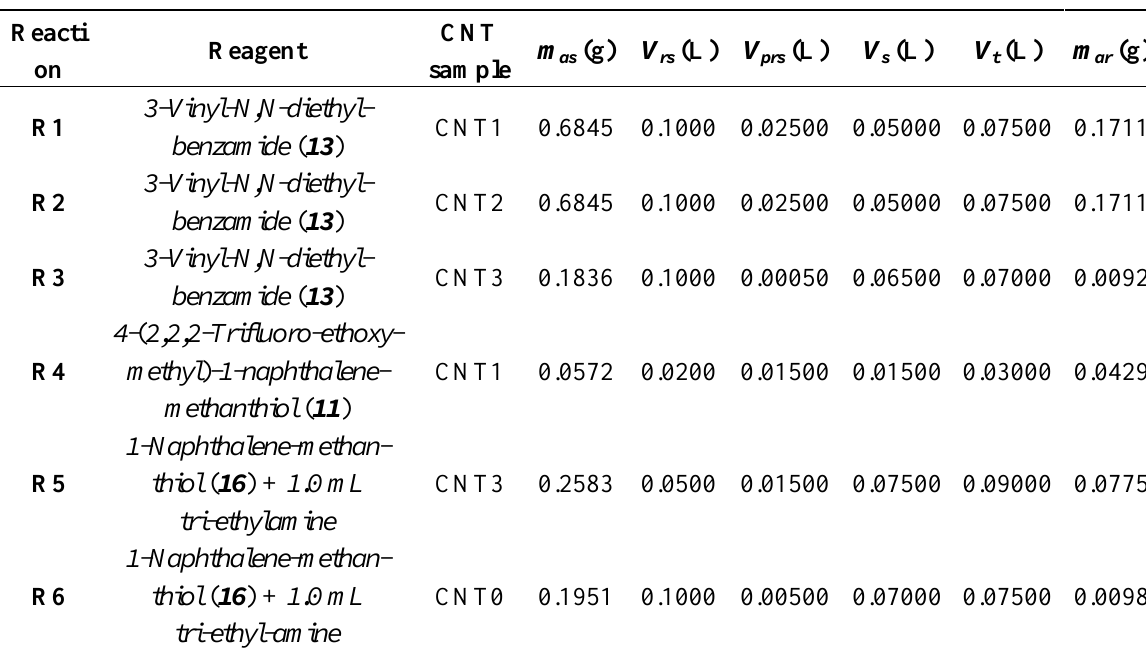
Table 6. Variables and values for the preparation of the reaction solutions for the reactions R1 to R6 .